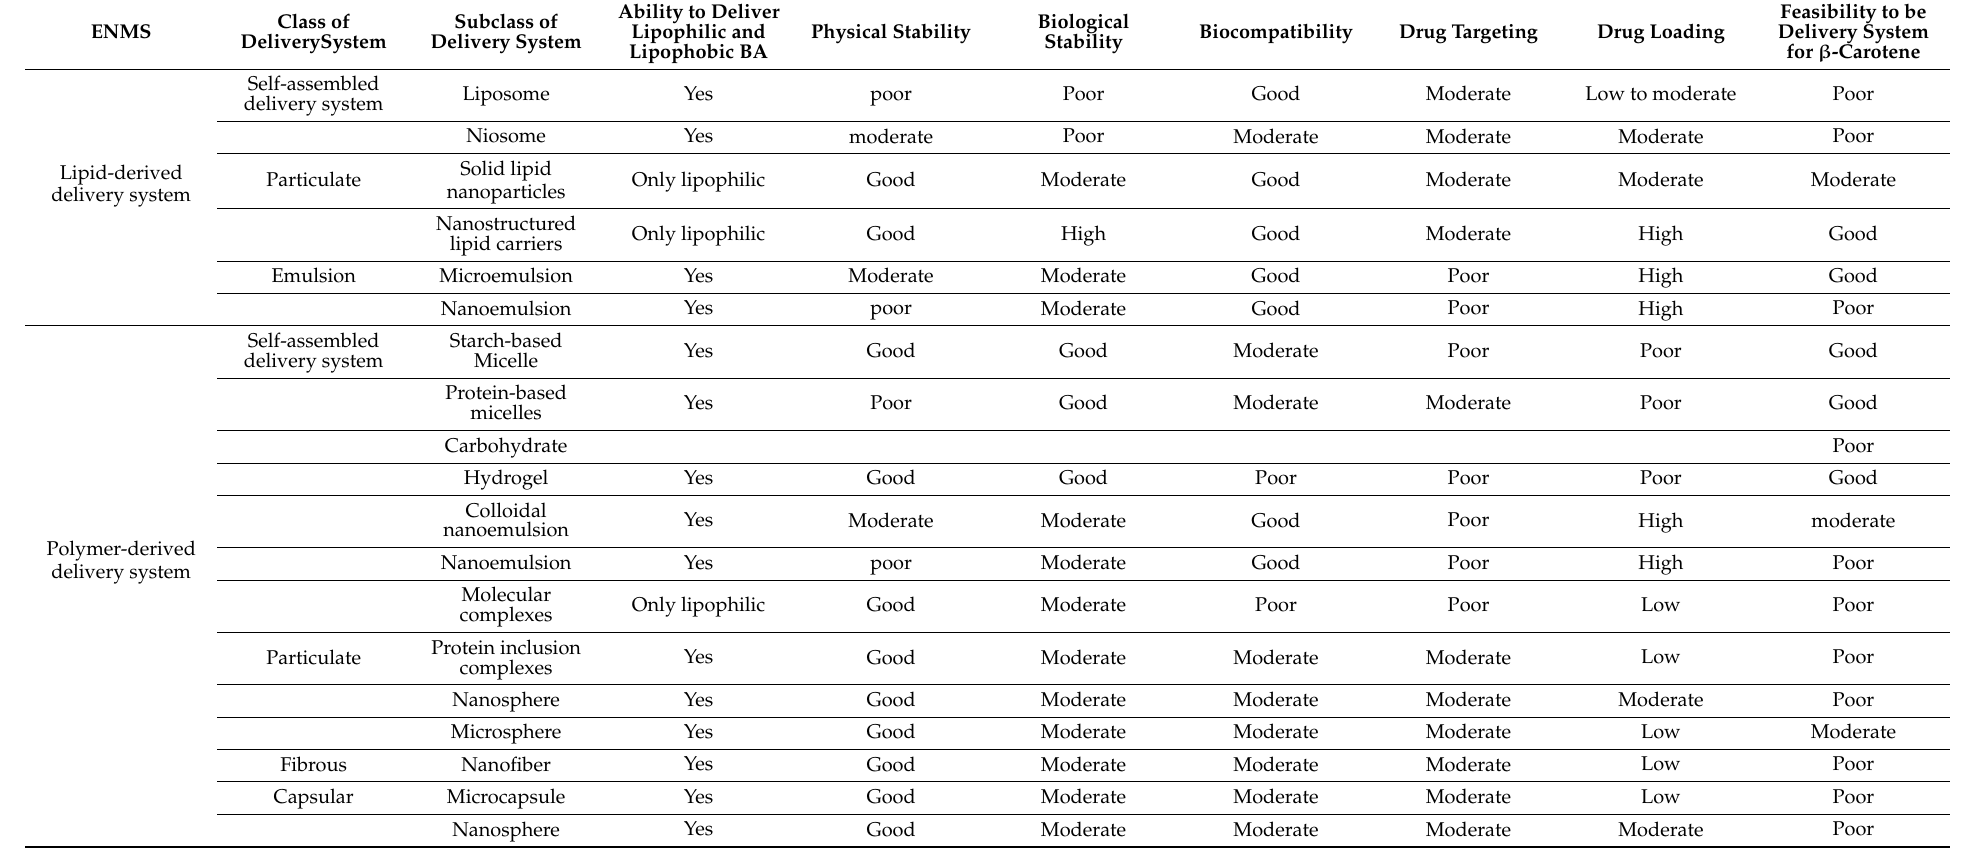
Table 2. Various factors that need to be considered prior to selecting a delivery system for encapsulating any bioactive